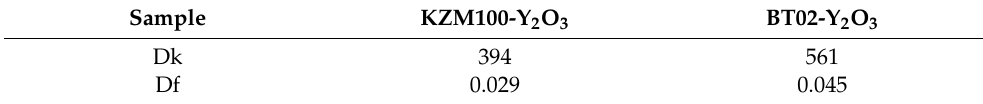
Table 1. Dielectric constant and tangent loss at 1 kHz of BaTiO 3 doped by different types of Y.